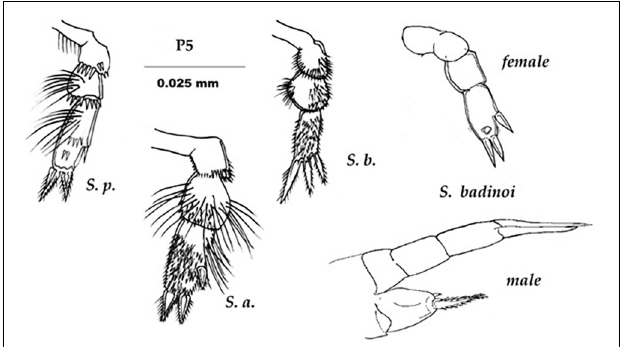
FIGURE 4 | Adult female, Stygocyclopia badinoi n.sp., paratype. P5, right ramus. Compared with P5 of other Stygocyclopia species. S.a. , ( Stygocyclopia australensis ); S.b. ( Stygocyclopia balearica ); S.p. ( Stygocyclopia philippensis ). Male damaged specimen. P5, both appendages. Scale bar, 0.025